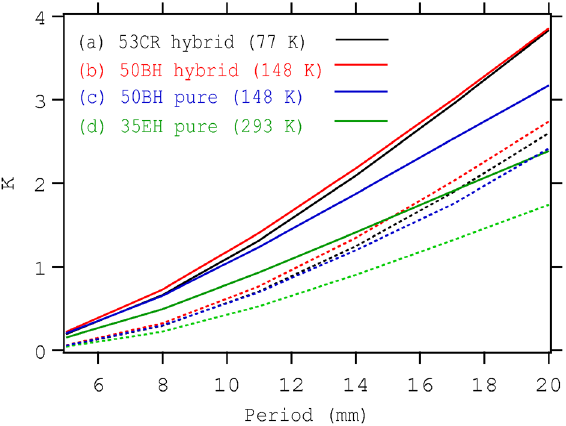
(2).FIG. 5. (Color) Peak magnetic field calculated for 14 mm pe- riod undulators. ( a ) 53CR (cid:5) Dy hybrid CPMU (77 K); ( b ) 50BH (cid:5) permendur hybrid CPMU (148 K); ( c ) 50BH pure magnet CPMU (148 K); ( d ) conventional 35EH pure magnet undulator (room temperature).